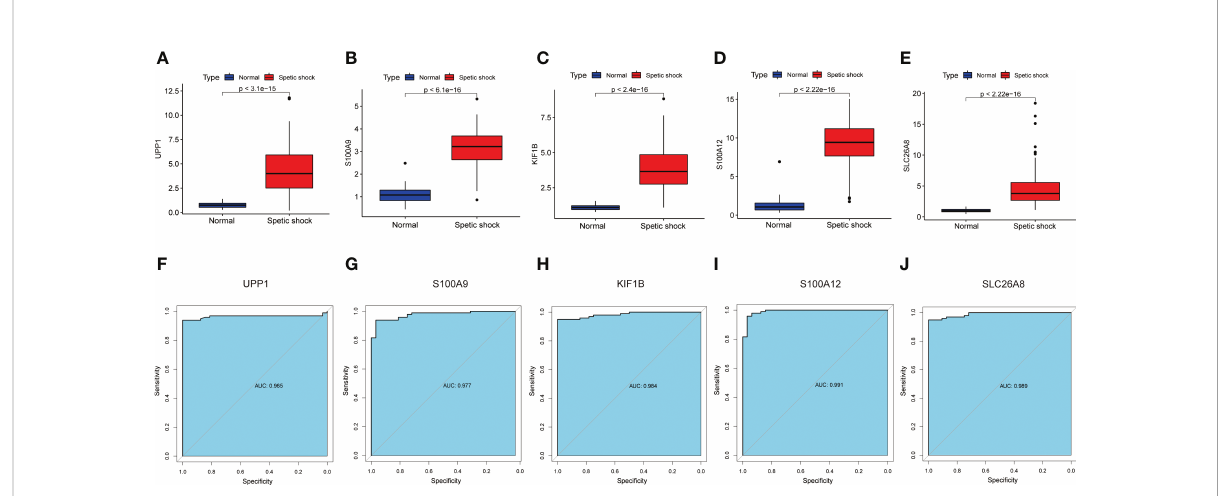
FIGURE 6 The performance of the signature genes in GSE26440. (A – E) The expression of signature genes between the pediatric septic shock and healthy cohort. (F – J) ROC showed the diagnostic performance of the signature genes.